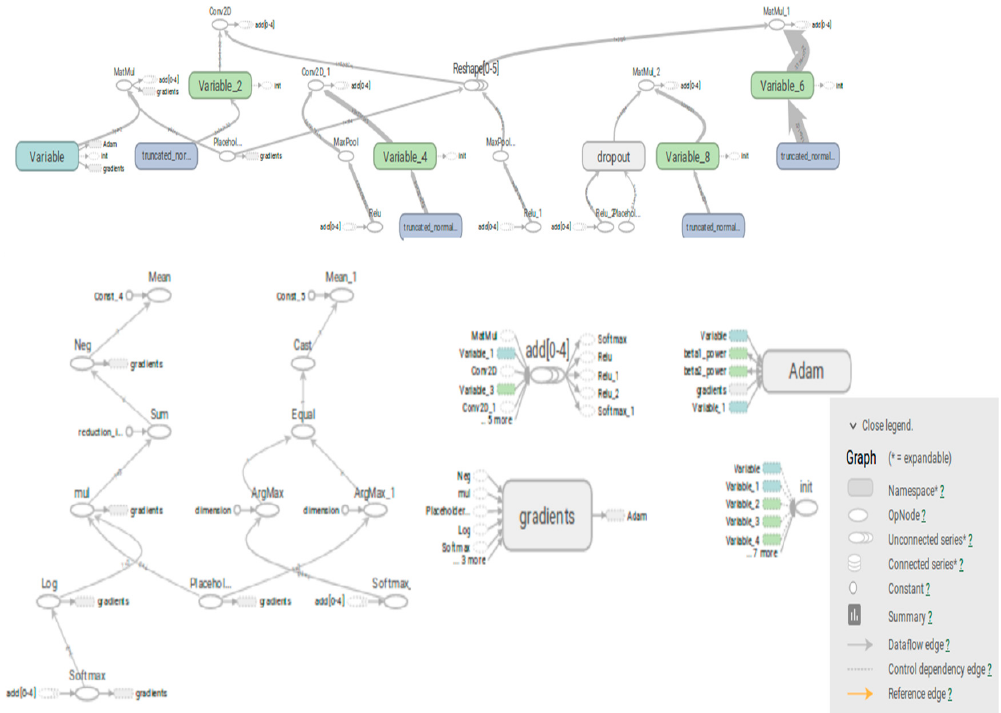
Figure 7. Structure using the convolutional neural network.